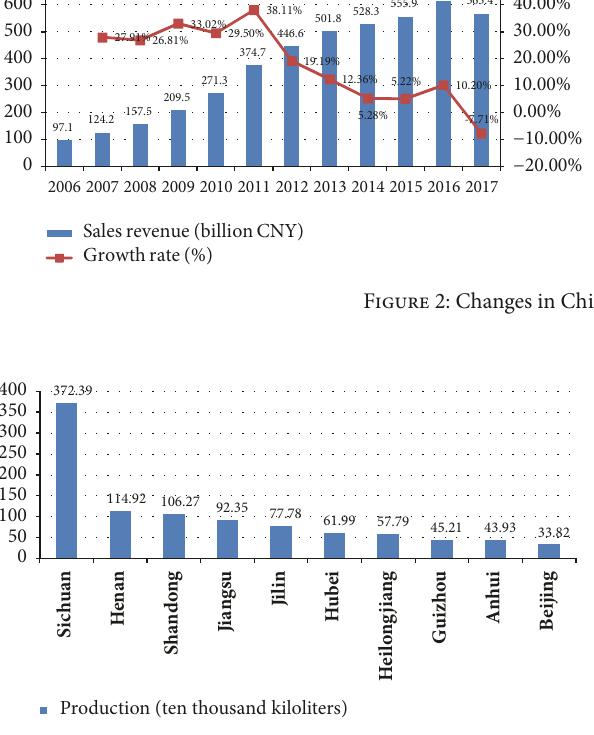
Figure 3: Baijiu production top ten list in